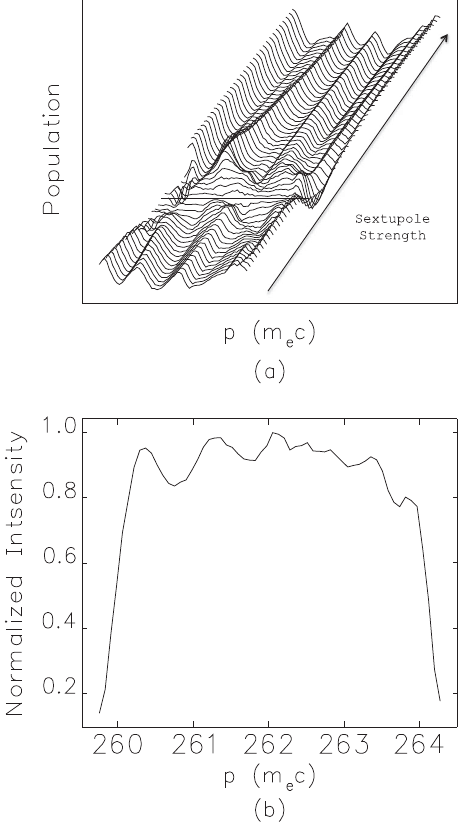
FIG. 8. (a) Mountain range plot of the energy spectrum difference from the baseline taken when the sextupoles are correctly set. The sextupole strength is scaled from 0 to 300% of the correct set point for linearizing the bunch. At the bottom left the sextupoles are completely off, while at the top right of the plot the sextupole strength has reach 300% of the correct set point. (b) Baseline momentum distribution when sextupoles are set to nominal